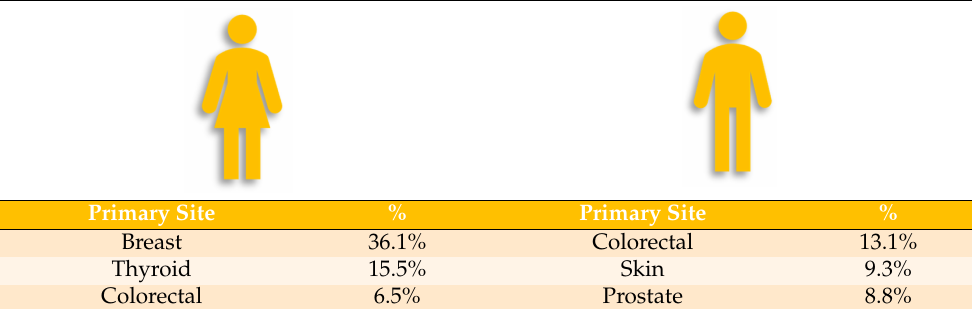
Table 2. Top ten most common malignant primary sites among females and males,